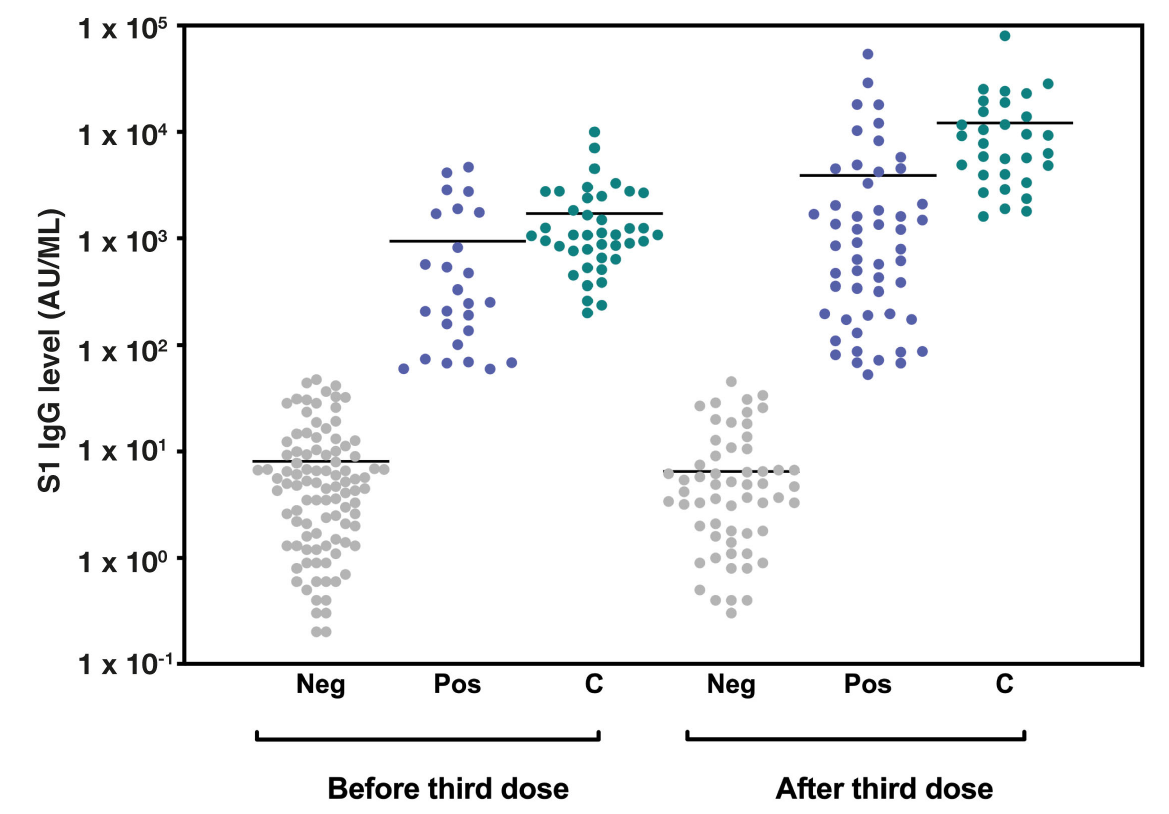
Figure 1. Seropositivity among LTRs and control group before and after the third vaccine dose. A column scatter plot graph representing the BNT162b2 vaccine-induced S1-IgG antibody levels (AU/mL) in lung transplant recipients and control group before and after the third vaccine dose. The bars represent median values. Abbreviations: LTRs, lung transplant recipients; AU, antibody units; Neg, LTRs with seronegative antibody titer: Pos, LTRs with seropositive antibody titer; C, control group antibody titer. Table 1. Demographic and clinical characteristics of study participants, stratified by seropositivity to anti-spike IgG antibodies after three vaccine